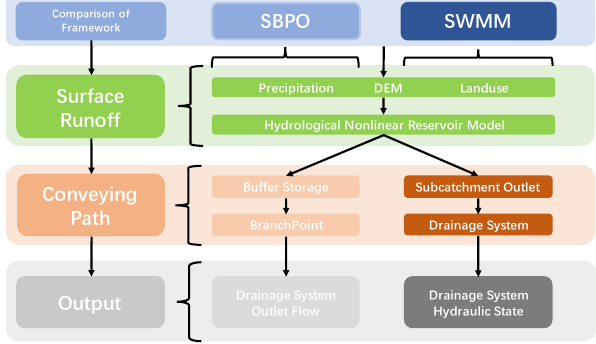
Figure 6. Model framework